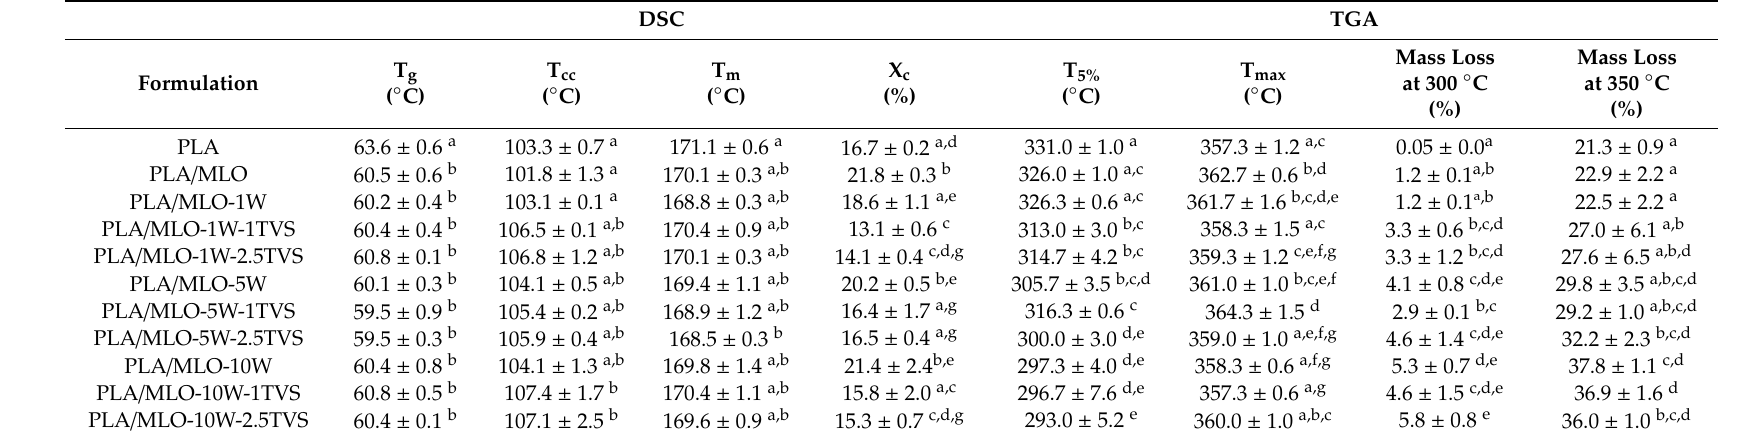
Table 2. Thermal properties of the